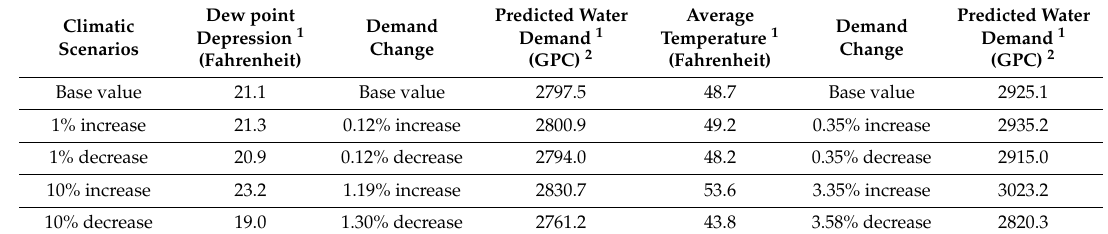
Table 6. Sensitivity analysis of change in monthly per capita water demand as a result of percent change of climates using the ARIMAX models.